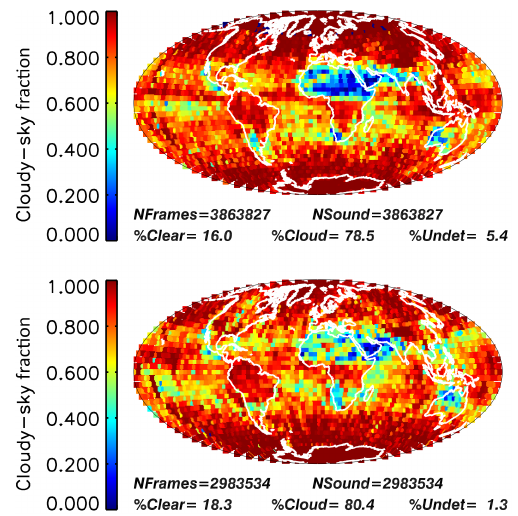
Figure 4. Cloudy-sky fraction calculated from the MODIS/OCO- 2 collocated cloud mask described in Sect. 3.2 for the December combined glint and nadir data sets (top) and the April–May data (bottom). Data are binned in 4 ◦ by 4 ◦ lat/long